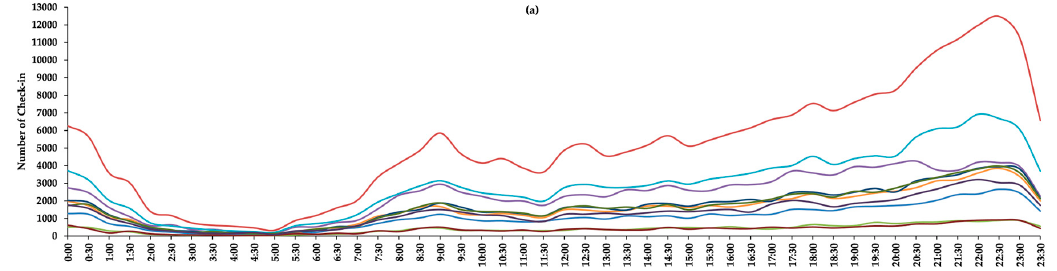
Figure 9. District wise activities distribution by men and women in Shanghai.